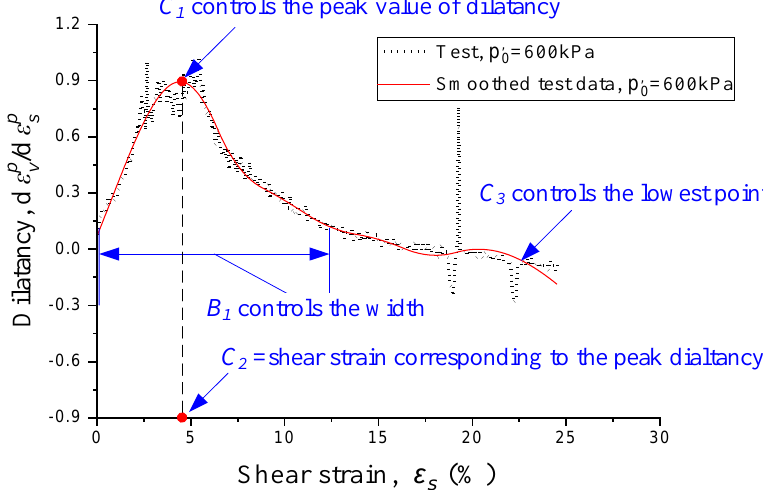
Figure 3. Smoothing test data for dilatancy fitting on the strain − dilatancy plane.